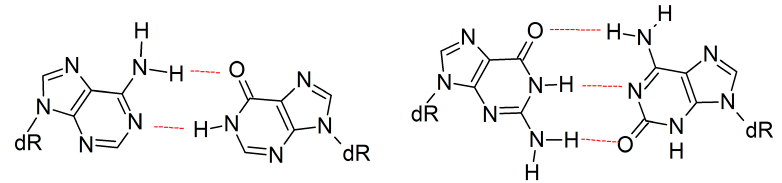
Figure 8. Examples of size-extended anti -purine: anti -purine mismatches.